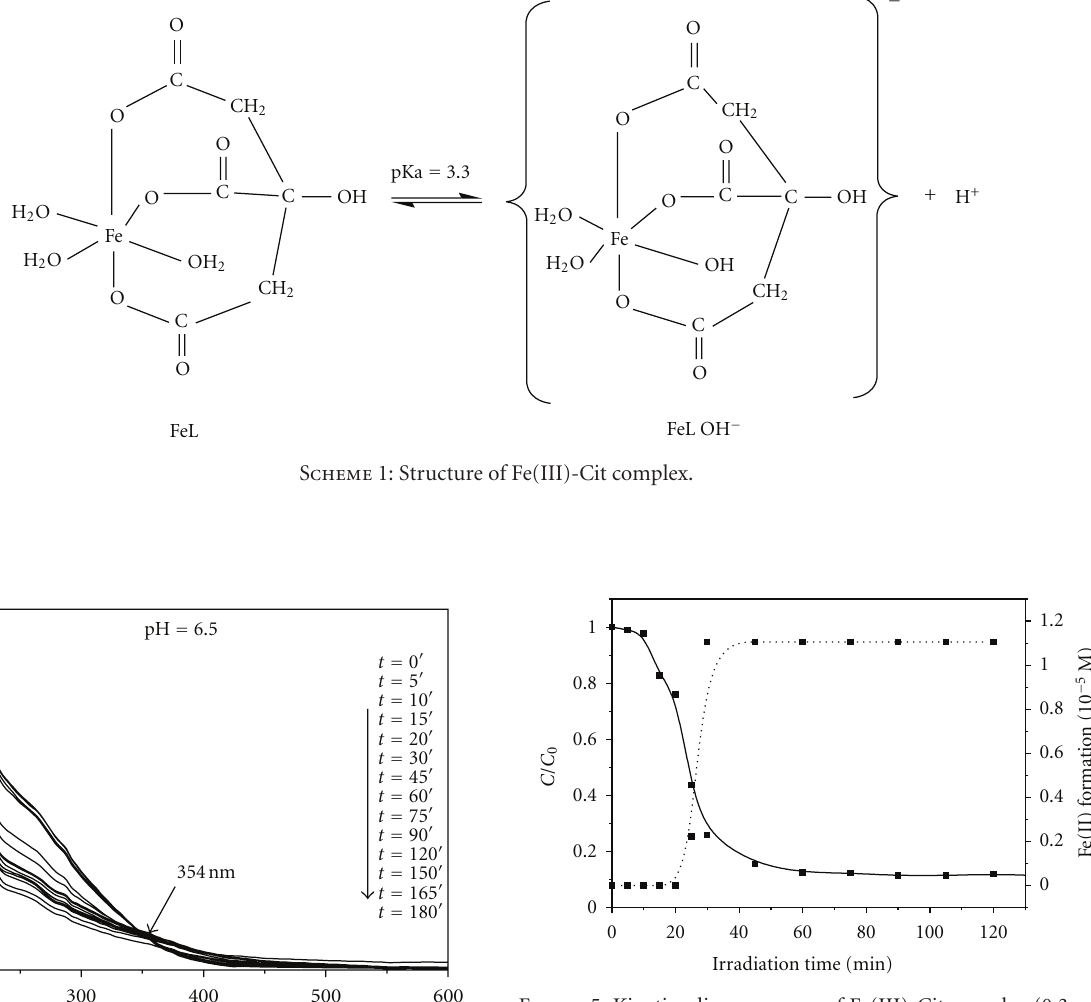
Figure 5: Kinetics disappearance of Fe(III)-Cit complex (0.3mM) and Fe(II)